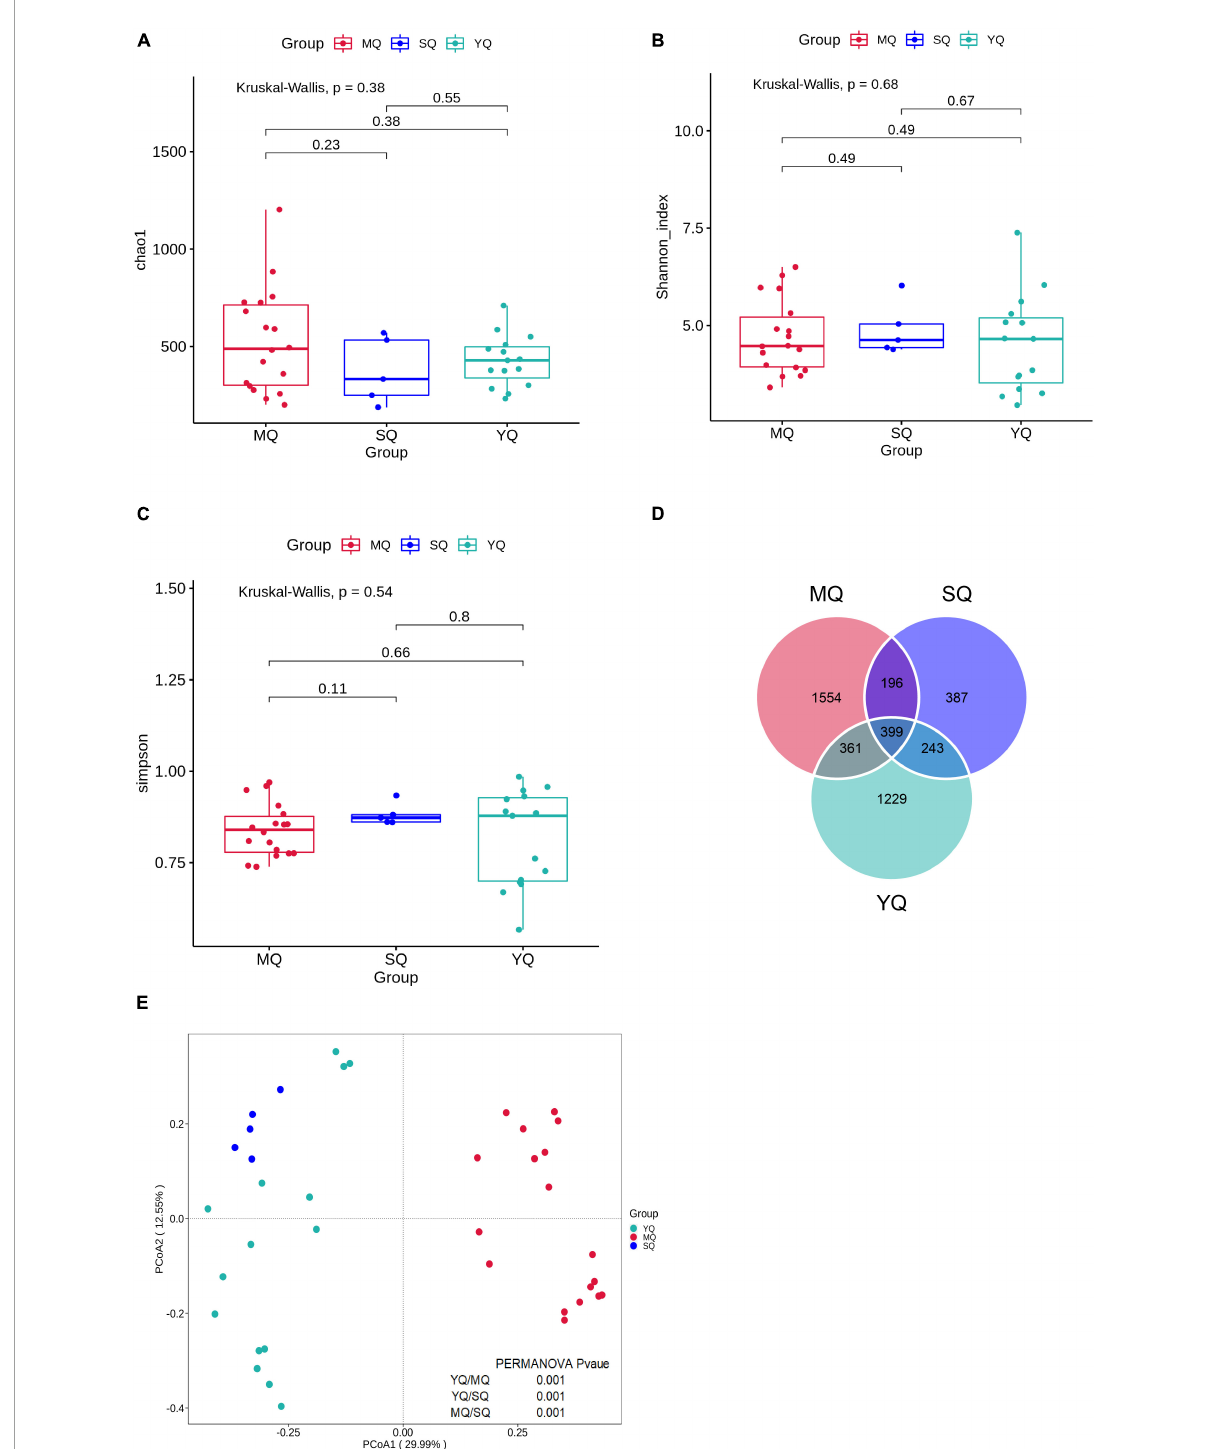
FIGURE1 Alpha and beta diversity of fecal microbiota among three ecological groups of birds (MQ, SQ, and YQ). Alpha diversity was characterized by Chao1 index (A) , Shannon index (B) , and Simpson indices (C) . Solid horizontal line within a box represents the median, the dots indicate the observed value, the box margins are the interquartile range (50% of the observations), and whisker lines extend for 1.5 times the interquartile range. There was no significant difference in Chao1 index, Shannon index, and Simpson indices ( p > 0.05). Venn diagram of ASVs overlapping across MQ, SQ, and YQ based on ASV presence and absence (D) . Principal coordinate analysis of fecal bacterial communities from the three groups of birds (E) . MQ, raptors; SQ, waders; YQ,